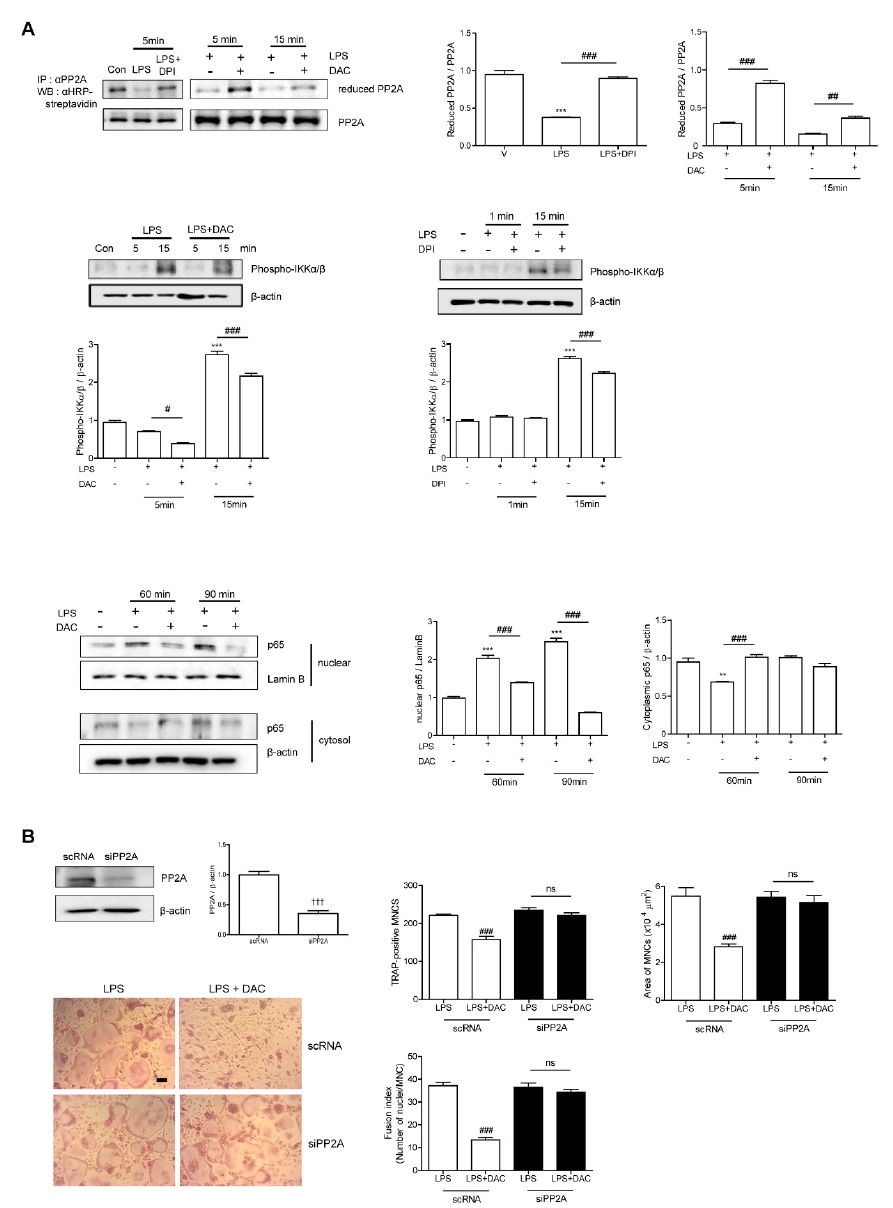
Figure 4. DAC decreases LPS-induced oxidation of PP2A to block NF-kB activation via decreasing the ROS level in OCs. Prepared BMMs were incubated with M-CSF and RANKL for 40 h, washed, and further incubation with M-CSF under indicated conditions (DPI, 5 nM; DAC, 7 µ M) in the presence of LPS (50 ng/mL) was performed. After the labeling of the cell lysate using N-(biotinoyl)-N’-(iodoacetyl) ethylenediamine BIAM, immunoprecipitation (IP) was performed with anti-PP2A and followed by HRP–streptavidin immunoblotting to evaluate the reduced form of PP2A. Whole cell extracts were analyzed with an antibody against phospho-IKK α / β . After fractionation into cytoplasmic and nuclear parts, each was evaluated by Western blot analysis with